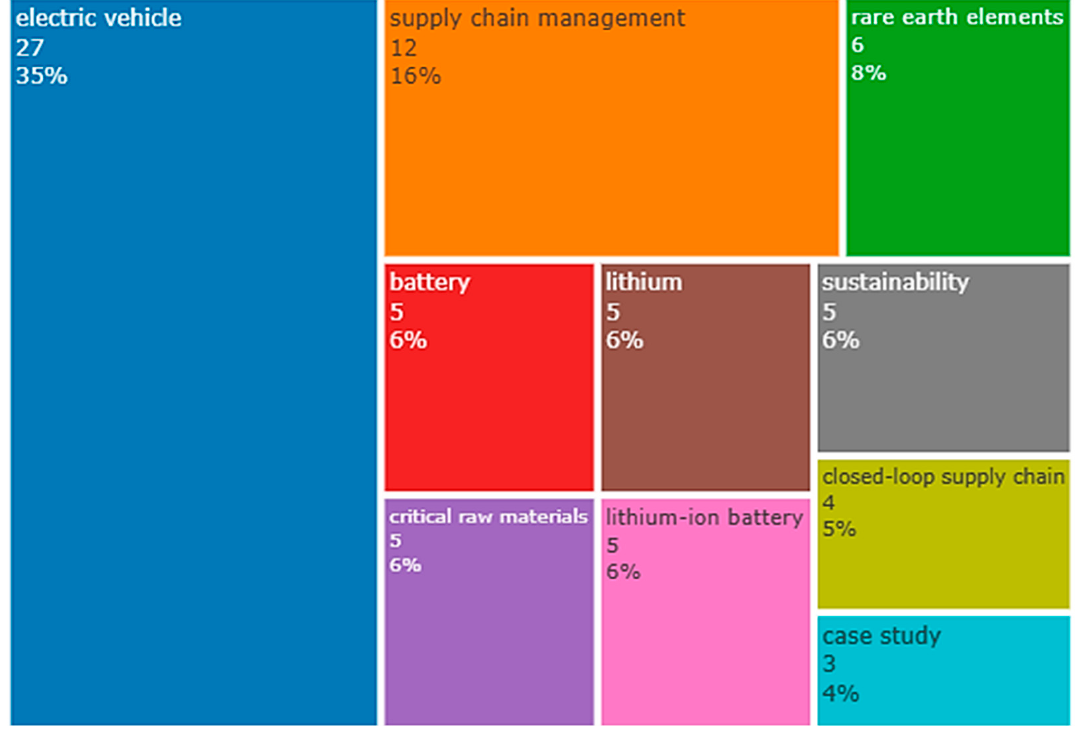
Figure 8 . Most relevant areas of research. (Visual produced by the Bibliometrix software). Figure 8. Most relevant areas of research. (Visual produced by the Bibliometrix